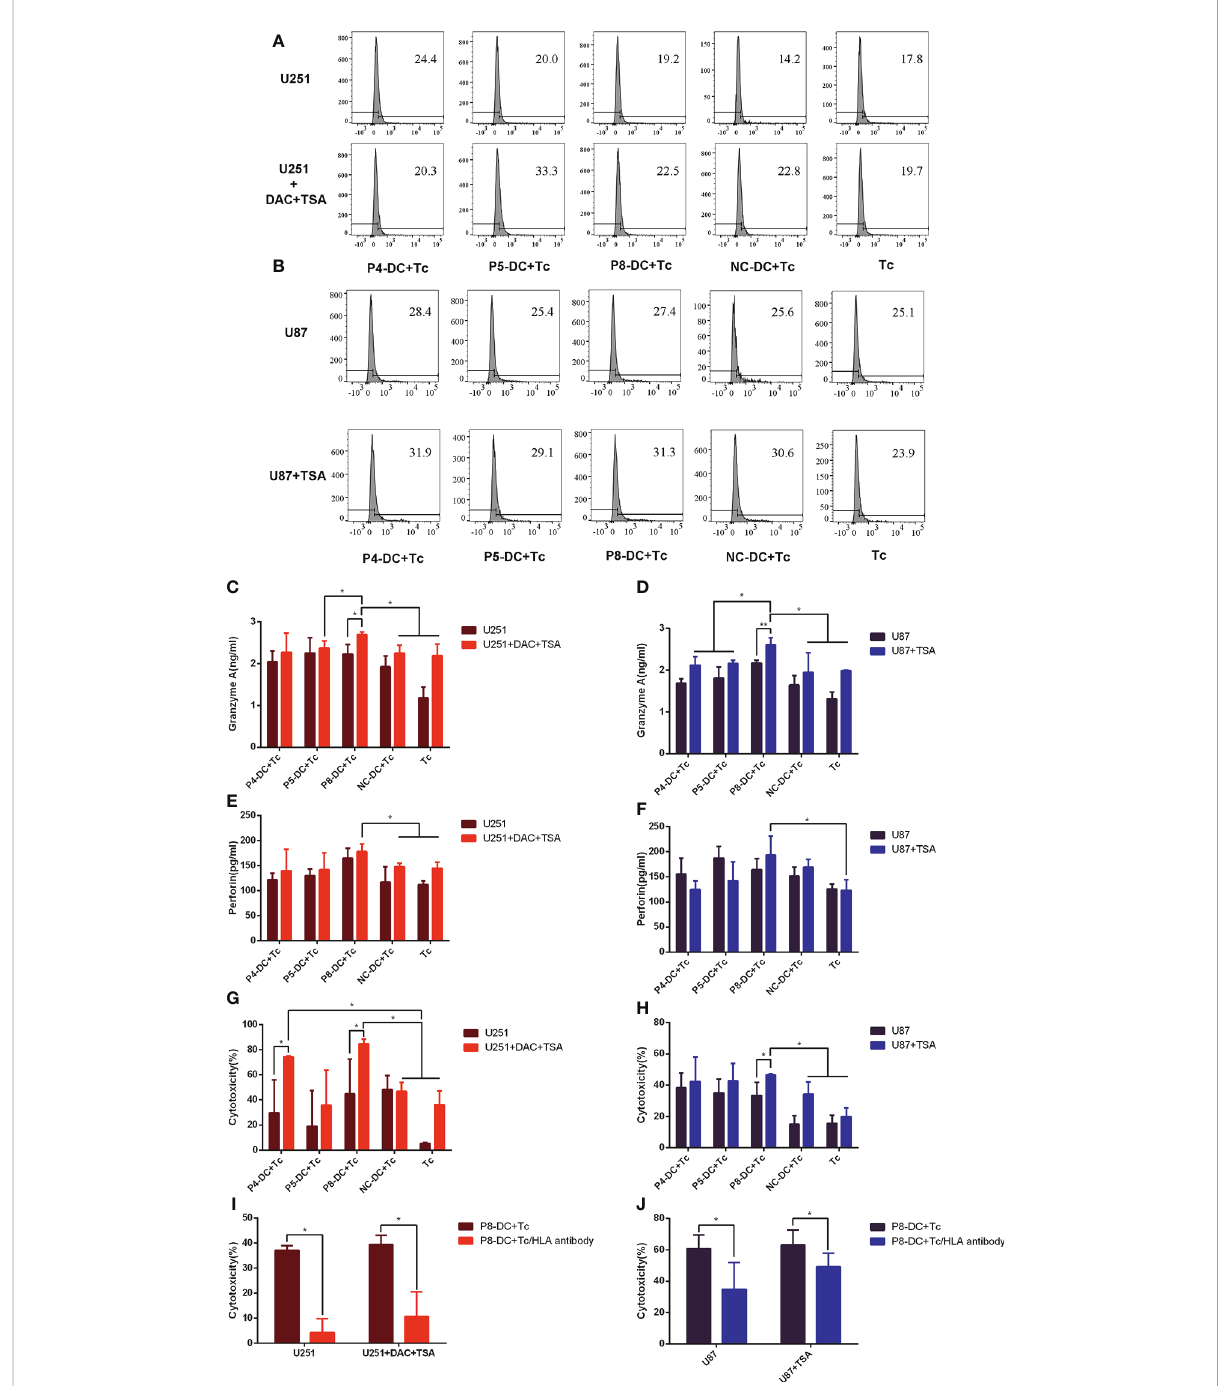
FIGURE 6 Epigenetic drugs sensitize tumor cells to the cytotoxicity of MAGE-D4-activated T cells. (A, B) the ratio of CD107a-expressed T cells stimulated by epigenetic drugs treated U251 (A) and U87 (B) cells. (C – F) the cytokines expression of T cells stimulated by epigenetic drugs treated U251 (C, E) and U87 (D, F) cells. (G) The anti-tumor activity of T cells against U251 treated by DAC and TSA. (H) The anti-tumor activity of T cells against U87 treated by TSA. (I) The cytotoxicity to DAC + TSA-treated U251 by P8 induced T cells blocked by Anti-HLA antibodies. (J) The cytotoxicity to TSA-treated U87 by P8 induced T cells blocked by Anti-HLA antibodies. DC, dendritic cell; Tc, T cell; NC, negative control peptide. *P